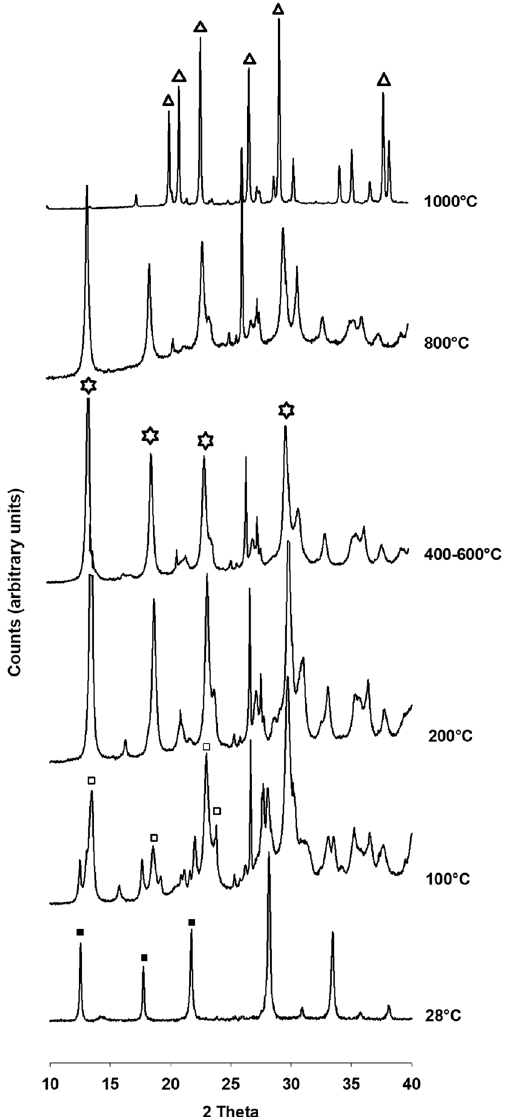
Figure 7. High temperature XRD pattern of sample at 91 h (100 °C). Full squares: Na-P 1 ; empty squares: tetragonal NaP; empty stars : phillipsite; full stars: